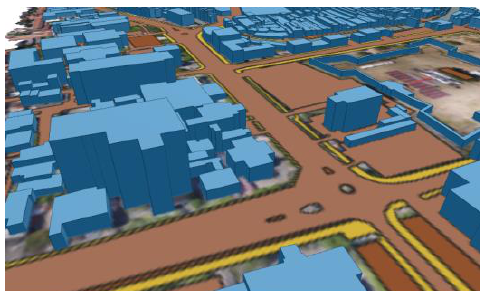
Figure 5. Editing and conversion of CityGML file using QGIS3